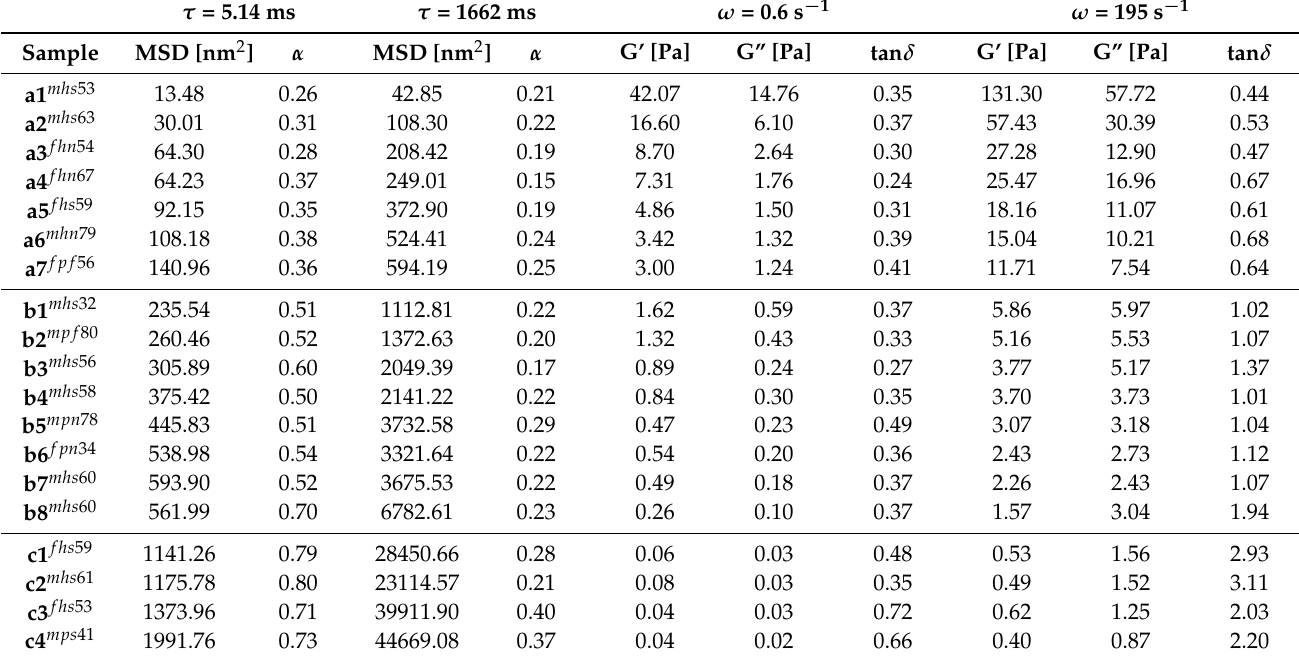
Table A1. MSD and diffusive exponents α at the evaluation limits τ = 5.14 ms and τ = 1662 ms, G’, G” and tan δ at ω = 0.6 s − 1 and ω = 195 s − 1 for all mucus samples. The superscripted digits give information about the demographic data of the patients, belonging to the mucus samples: 1. digit: gender (f: female, m: male); 2. digit: larynx status (h: healthy,